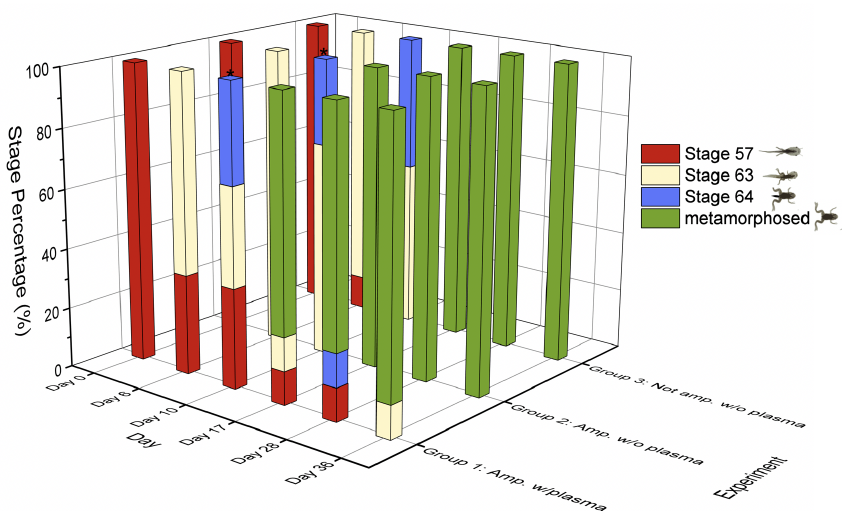
Figure 2. Graphic representation of developmental stages in metamorphosis impacted by tail amputation and plasma exposure. See Appendix A for details of developmental stages (57, 63, 64). At stage 57, three groups of tadpoles were divided as follows: Group 1: amputated and treated with plasma (experimental tadpoles). Group 2: amputated and not treated to plasma (control tadpoles). Group 3: not amputated and not treated to plasma. At day 6, in group 1, 40% of tadpoles were at initial stage 57 and the rest had progressed to stage 63, whereas, in group 2, all the tadpoles were at stage 63 and in group 3, 90% of tadpoles were at stage 63. At day 10 in group 1, approximately equal number of tadpoles (30 to 33%) were at stage 57, 63 and 64 compared to group 2 and 3, where approximately 80% of tadpoles were at stage 63 and the rest at stage 64. By day 17, in group 1, an equal percentage (15%) were at stage 57 and 63 and the rest had developed into froglets compared to groups 2 and 3 where all the tadpoles had metamorphosed into froglet. By day 36, in group 1, 90% of the tadpoles had metamorphosed into froglets.